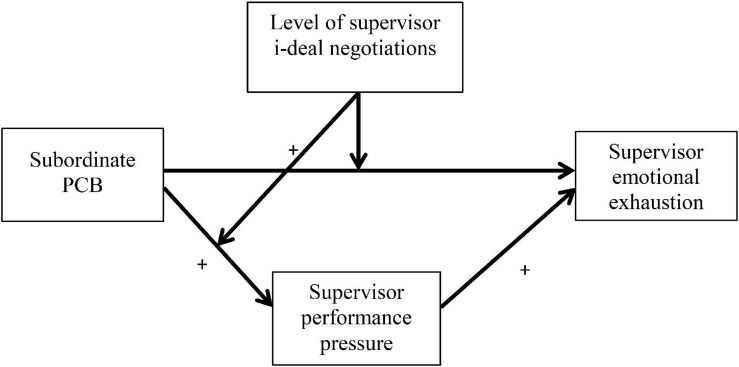
Theoretical model.